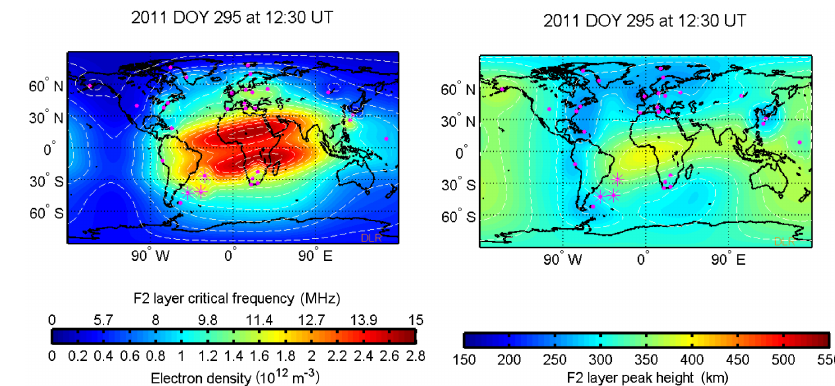
Figure 5. Reconstructed Nm F2/ fo F2 (left) and hm F2 (right) maps.